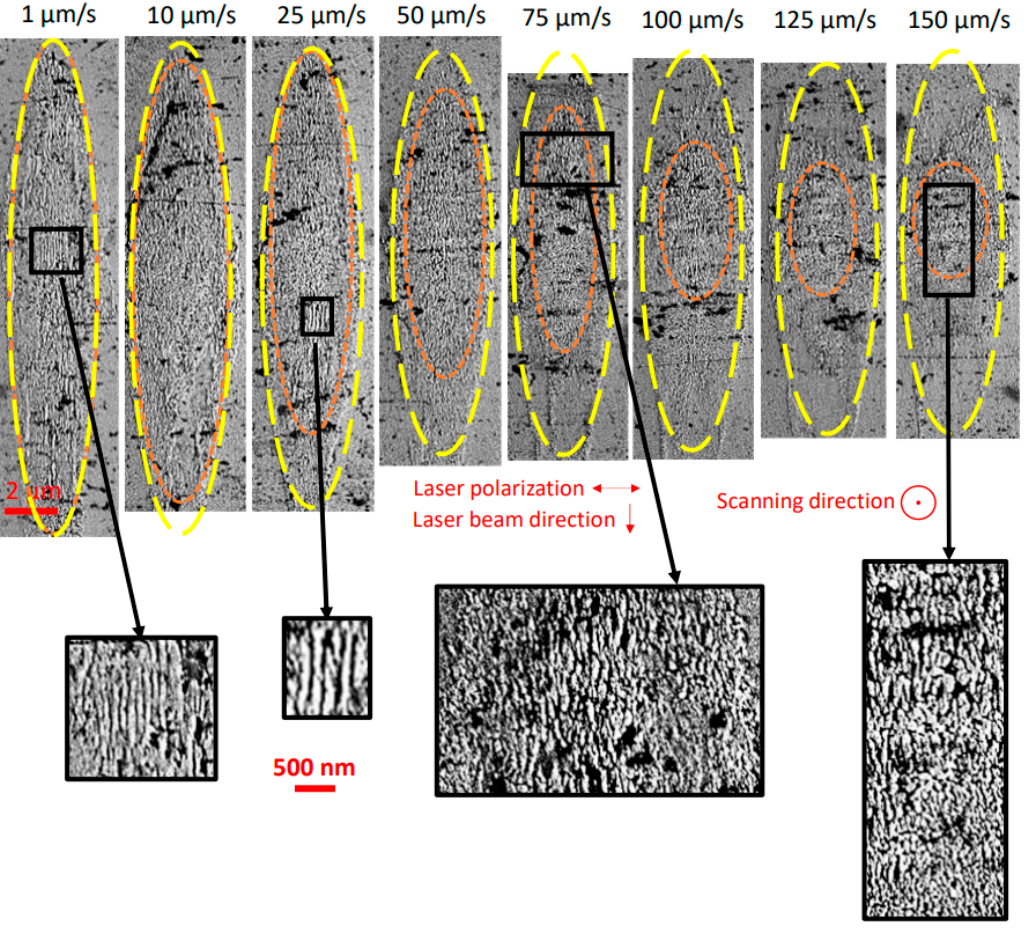
Figure 7. Scanning electron micrographs of the laser track cross-sections induced by fs-laser on LNSB glass sample and for different scanning speeds. The surrounded areas are (i) in yellow: area where crystallization within the laser track, associated with crystallization, is detected; and (ii) in orange: area where lamella-like nanogratings are observed (see for example insets). Other (fixed) parameters are: pulse energy = 0.5 µJ; configuration = Yx (laser polarization ⊥ to the scanning direction); λ = 1030 nm; f = 200 kHz; NA = 0.6; pulse duration = 250 fs; focal depth: 240 µm (in air). N.B. the crystallized volumes (in yellow) are similar to the ones in the Yy configuration (Figure 6).